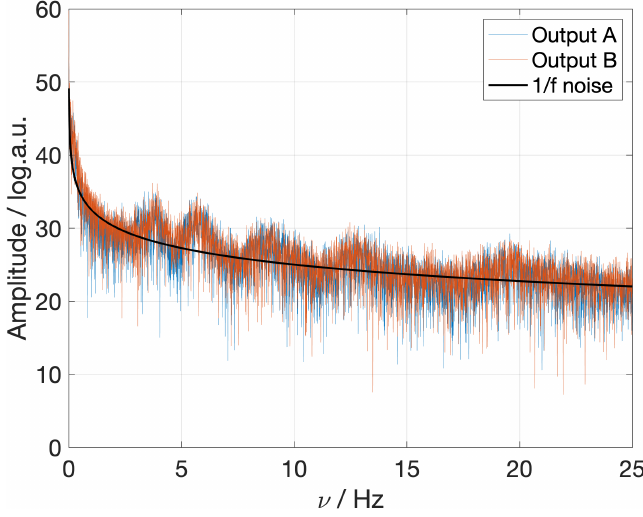
Figure 6. Fast Fourier Transform (FFT) of the measured signal obtained without external phase modulation. The black line represents a 1/ f noise, as an illustration. The amplitude units correspond ( A ) where A is the FFT of the to 10log 10